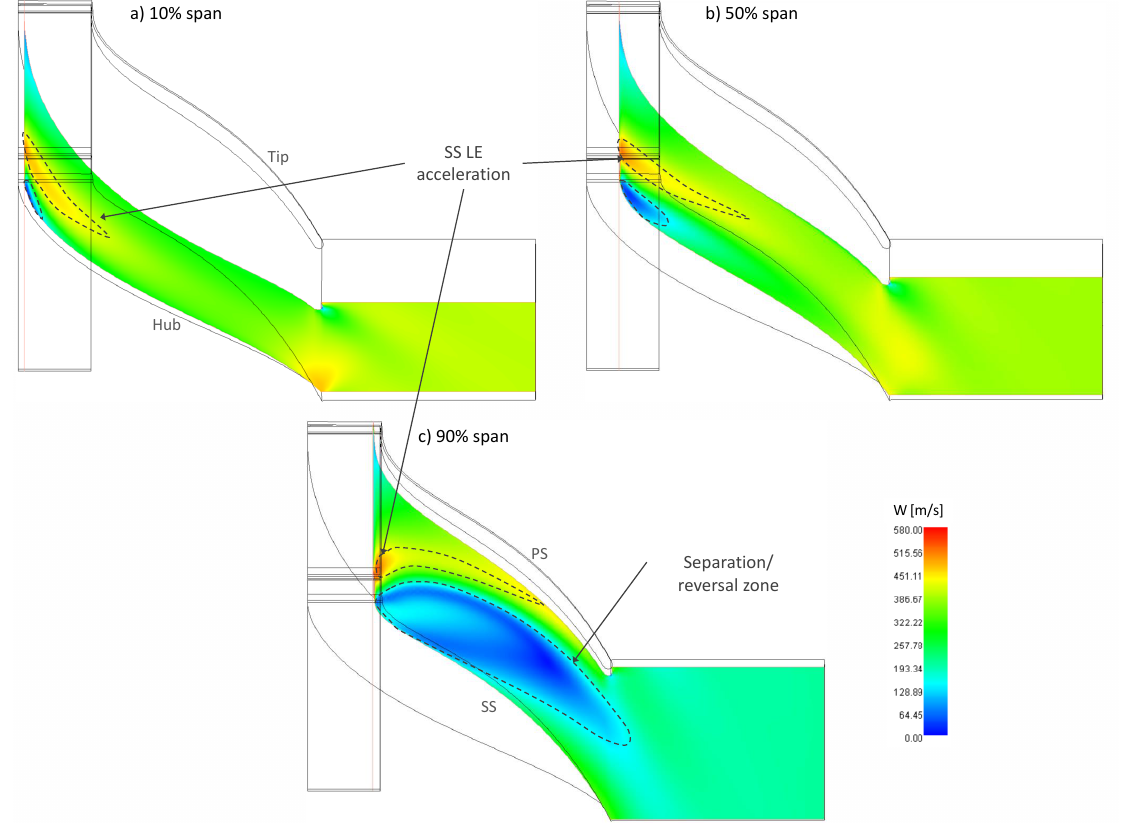
Figure 6. Relative velocity contour at three spansiwse rotor passage locations: ( a ) 10% span, ( b ) 50% span, ( c ) 90%